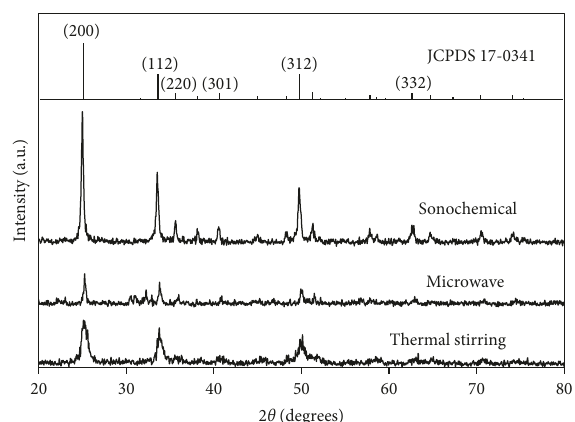
3+ nanoparticles synthe- 4 :Eu